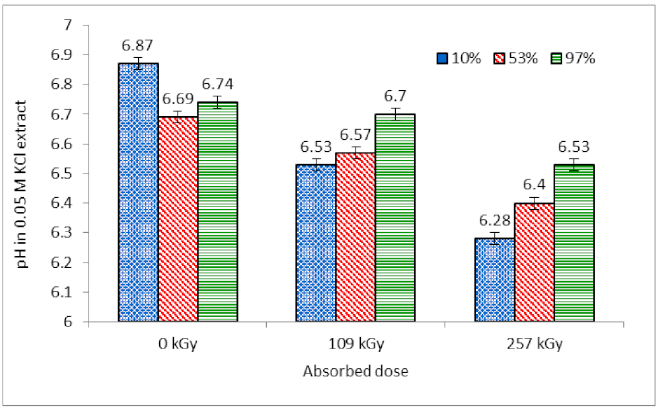
Figure 8. Variation of pH in 0.05 molar KCl extracts from wool depending on absorbed dose for different RH (%) in conditioning prior to irradiation. Measurements were performed 353 days after irradiation and subsequent free storage under laboratory